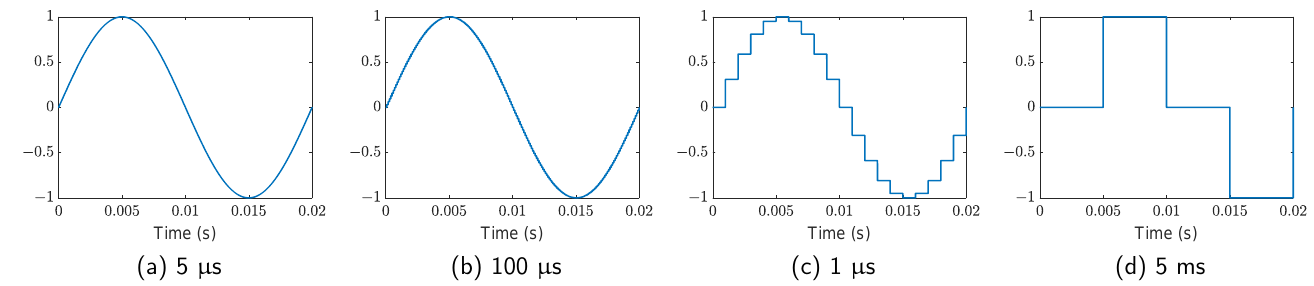
Figure 9. Simulink model of a threephased middle voltage grid.